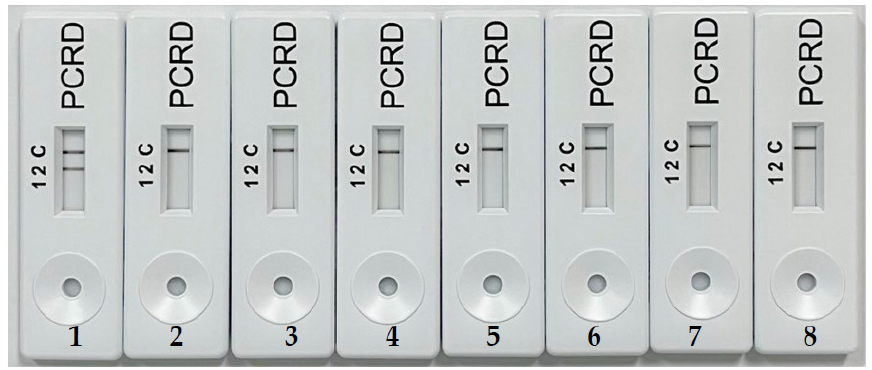
Figure 2. Specificity analysis of porcine DNA labelled primer by RPA with NALFIA; 1—pork; 2— beef; 3—mutton; 4—dog; 5—chicken; 6—duck; 7—rabbit; 8—no template control (ntc).